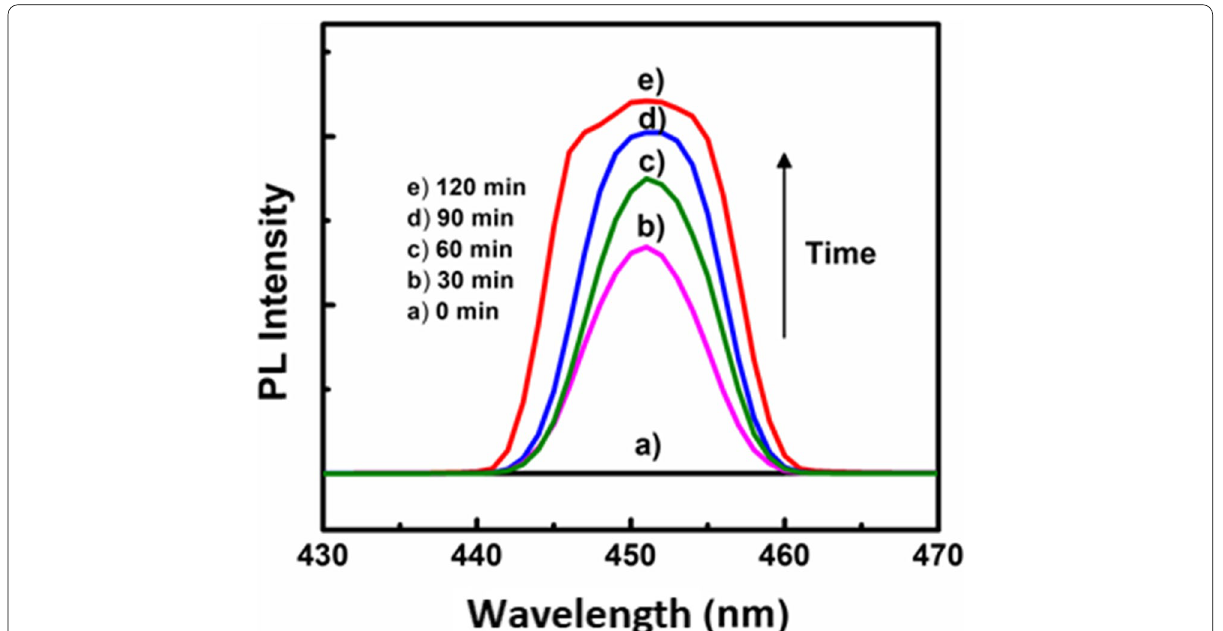
Fig. 17 Photoluminescence Spectra of ZMT4S2, catalyst dosage (0.1 g 100 mL − 1 ), dye concentration (10 mg L − 1 ), pH 3